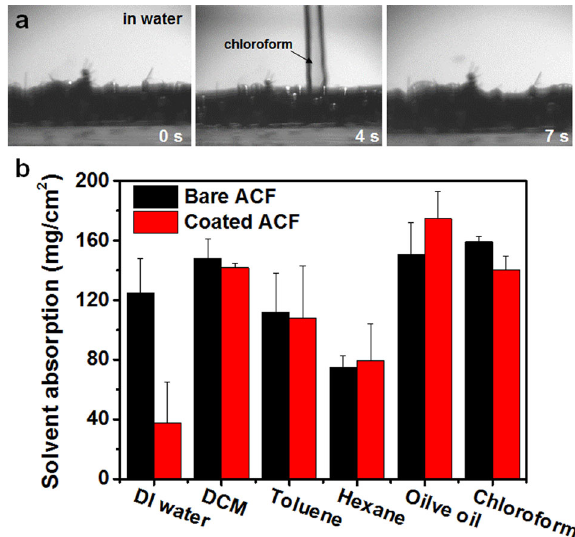
Fig. 4 Wettability and water-oil selective properties of F-PU in- and-out coated ACF. a Photographs of the fl ow of CF on the F-PU in-and-out-coated ACF in aqueous condition. b Absorption capacity (mg/cm2) of the bare ACF and F-PU in-and-out-coated ACF for DI water, dichloromethane (DCM), toluene, hexane, olive oil, and CF. The error bars represent the standard deviations of the